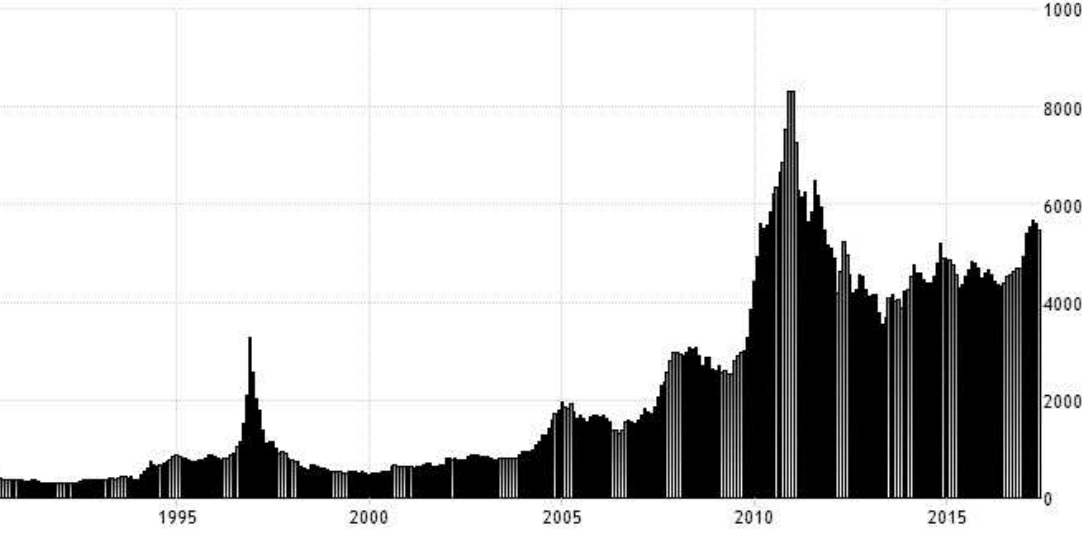
Figure 1. Dhaka Stock Exchange performance from 1990 to